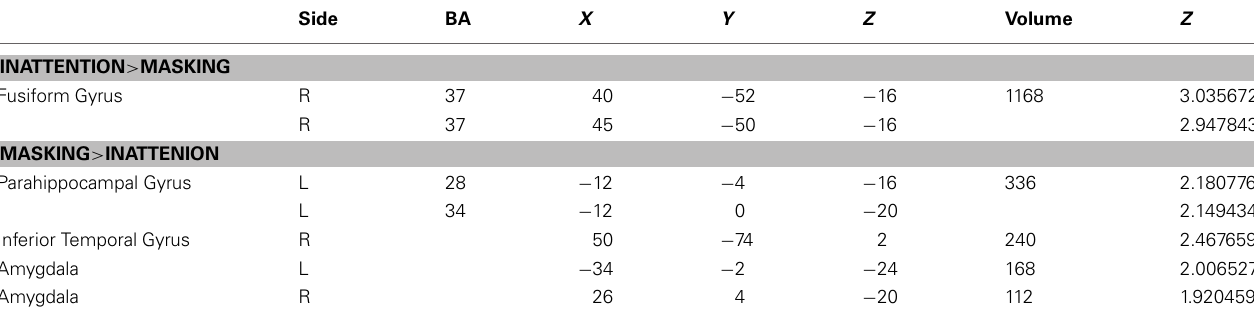
Table 3 | Comparison between